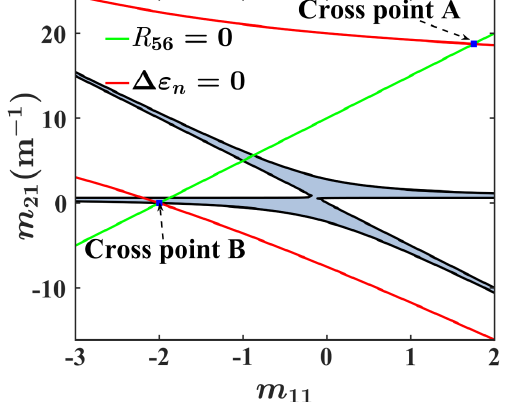
FIG. 2. The stable area (shaded) and the requirements of m 21 as a function of m 11 derived from the imposed constraint of R 56 ¼ 0 (green line) and Δ ε n ¼ 0 (red line). The cross points are marked (blue